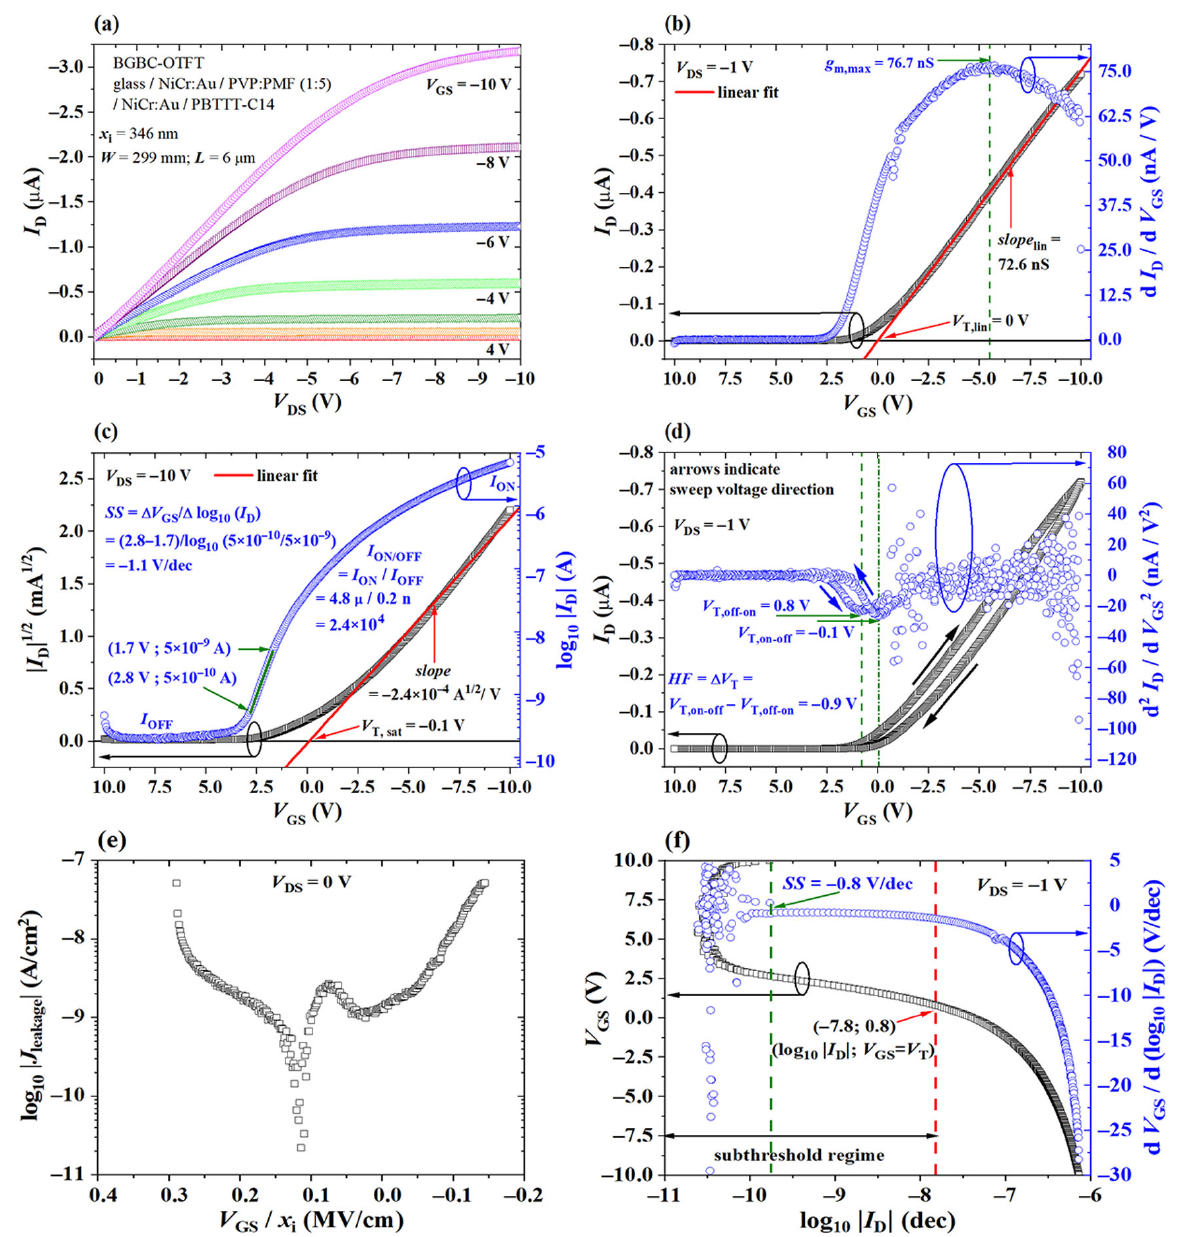
Figure 4. P-type FET characteristic curves: ( a ) I D versus V DS for V GS from 4 to − 10 V. ( b ) Left axis: I D versus V GS for V DS = − 1 V to illustrate the linear fit for µ and V T calculation in triode operation. Right axis: g m versus V GS for µ calculation from g m , max . ( c ) Left √ I D versus V GS for V DS = − 10 V to illustrate the linear fit for µ and V T calculation in saturation. Right axis: I D versus V GS in axis: logarithmic scale to extract I ON and I OFF , and calculate an approximate value for SS . ( d ) Left axis: off-to-on and on-to-off I D versus V GS scans for V DS = − 1 V featuring hysteresis. Right axis: plot of the second derivative of I D with respect to V GS to extract V T and illustrate the hysteresis factor calculation. ( e ) J leakage versus the perpendicular electric field in the channel ( V GS / x i ) for V DS = 0 V. ( f ) Plot of V GS versus log 10 | I D | and its first derivative to illustrate SS calculation. All data were extracted from